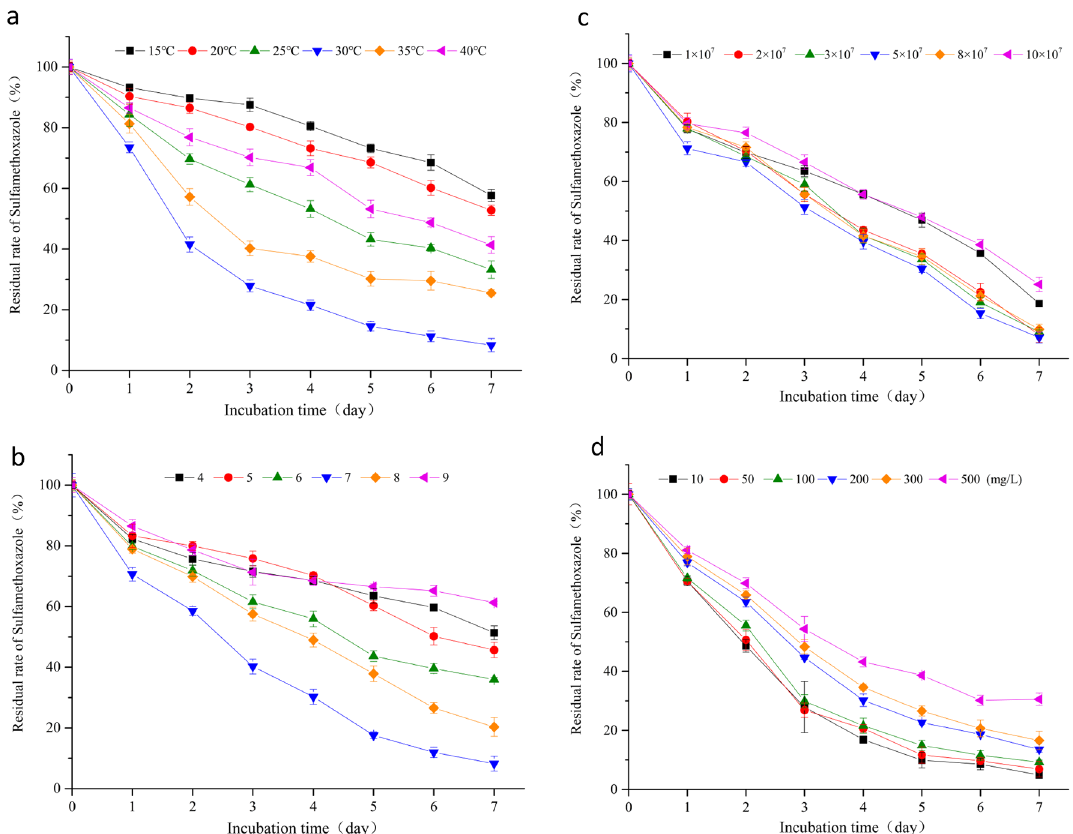
Figure 3. Degradation kinetics of SMX under different conditions ( a ) temperature (°C), ( b ) pH level, ( c ) inoculum amount (× 10 7 cfu/mL), and ( d ) initial concentration (mg/L) of SMX. The symbols represent averages of triplicate experiments and the error bars indicate their corresponding standard